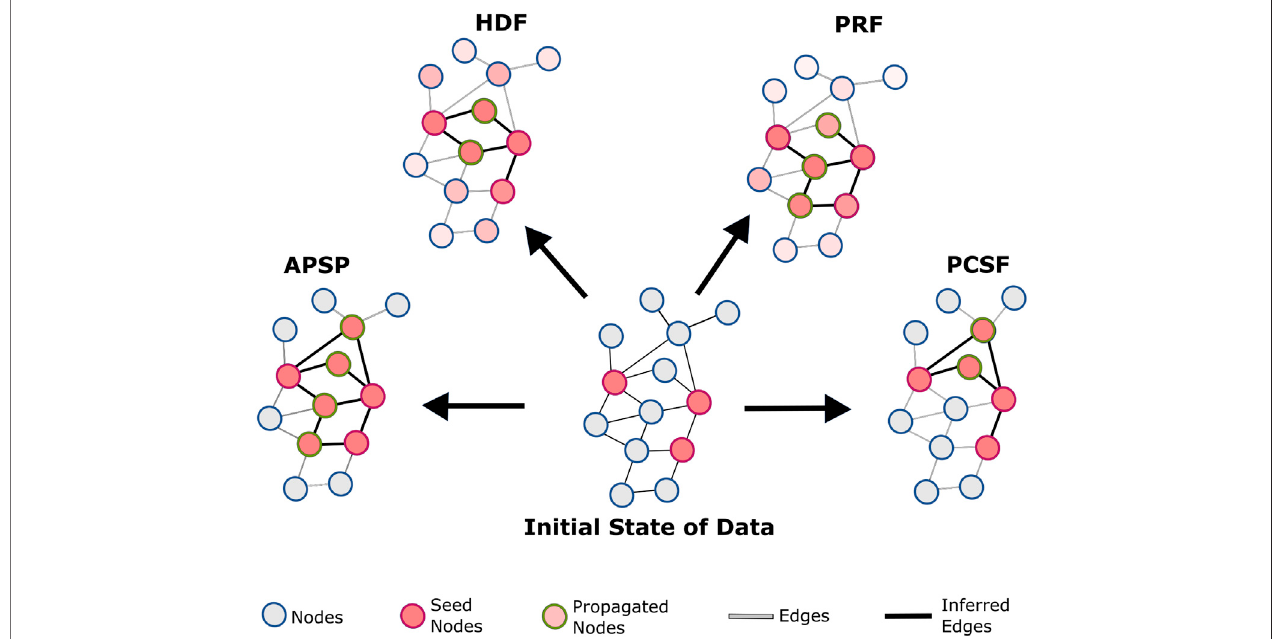
FIGURE 1 | Conceptual representation of reconstruction algorithms: all-pair shortest paths (APSP), personalized PageRank with fl ux (PRF), heat diffusion with fl ux (HDF),andprize-collectingSteinerforest(PCSF).IntheAPSP,thesubnetworkisreconstructedwiththeunionofallshortestpathsbetweenseednodes.HDFdiffusesthe heat that initially belongs to seed nodes. After limited steps of transfer, the heat of the nodes is used for fl ux score calculations for edges. PRF uses a personalized PageRank algorithm to fi nd the probability of nodes after randomly walking in the reference interactome and calculates fl ux scores. PCSF fi nds the optimum forest to link seed nodes either directly or through intermediate nodes. The union of optimum forests reconstructs subnetworks.